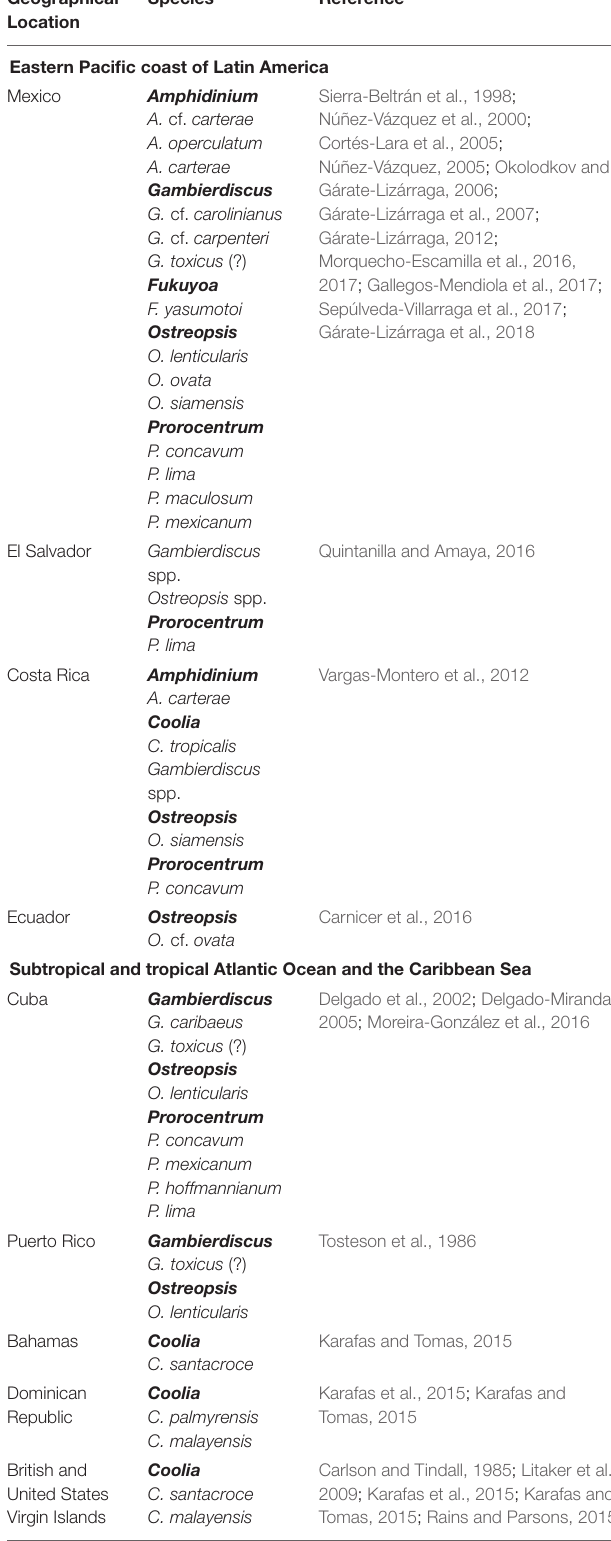
TABLE 1 | Potentially toxic benthic dinoflagellate species reported in Latin America and adjacent subtropical